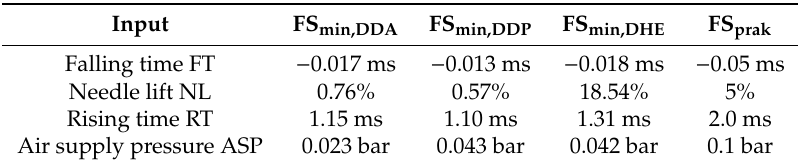
Table 3. Selection of feasible factor levels for optimization approaches using the statistical design of